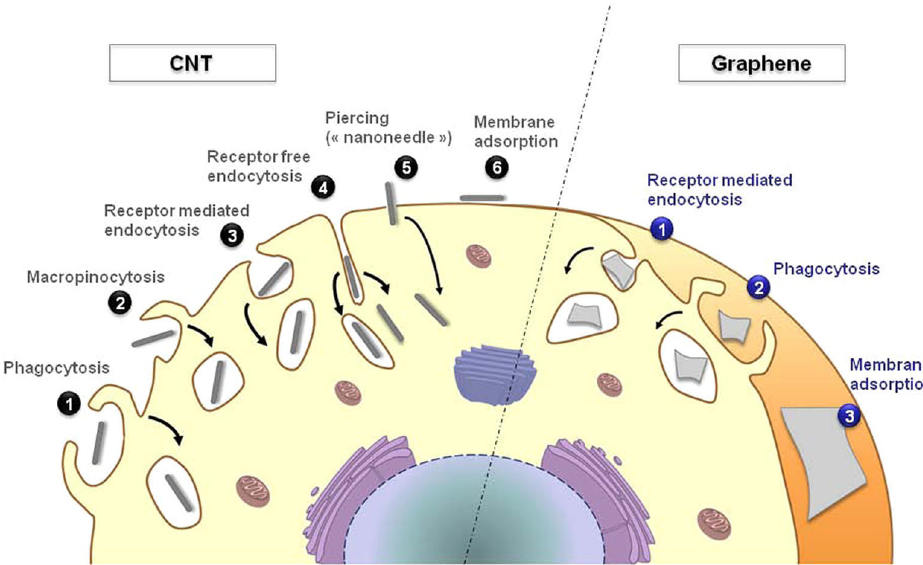
Figure 2. Schematic route of the cellular uptake of both neat CNTs and graphene-related materials. Reprinted with permission from Bussy et al. [27] (Copyright 2012 American Chemical Society).